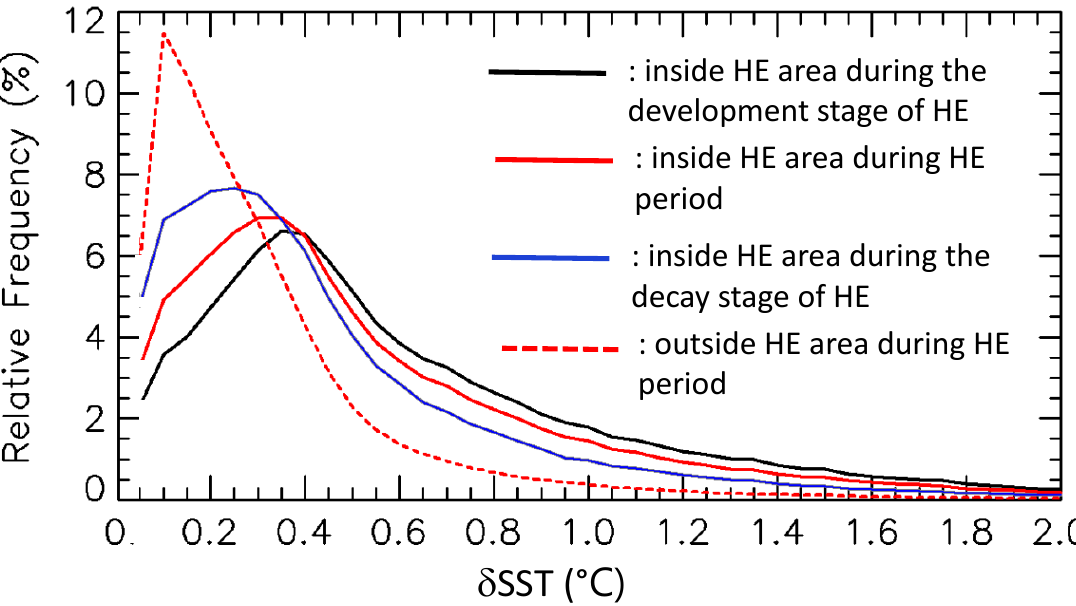
Figure 7. Histograms of the mean relative frequencies of δ SST values, with discrete intervals of 0.05 ◦ C.